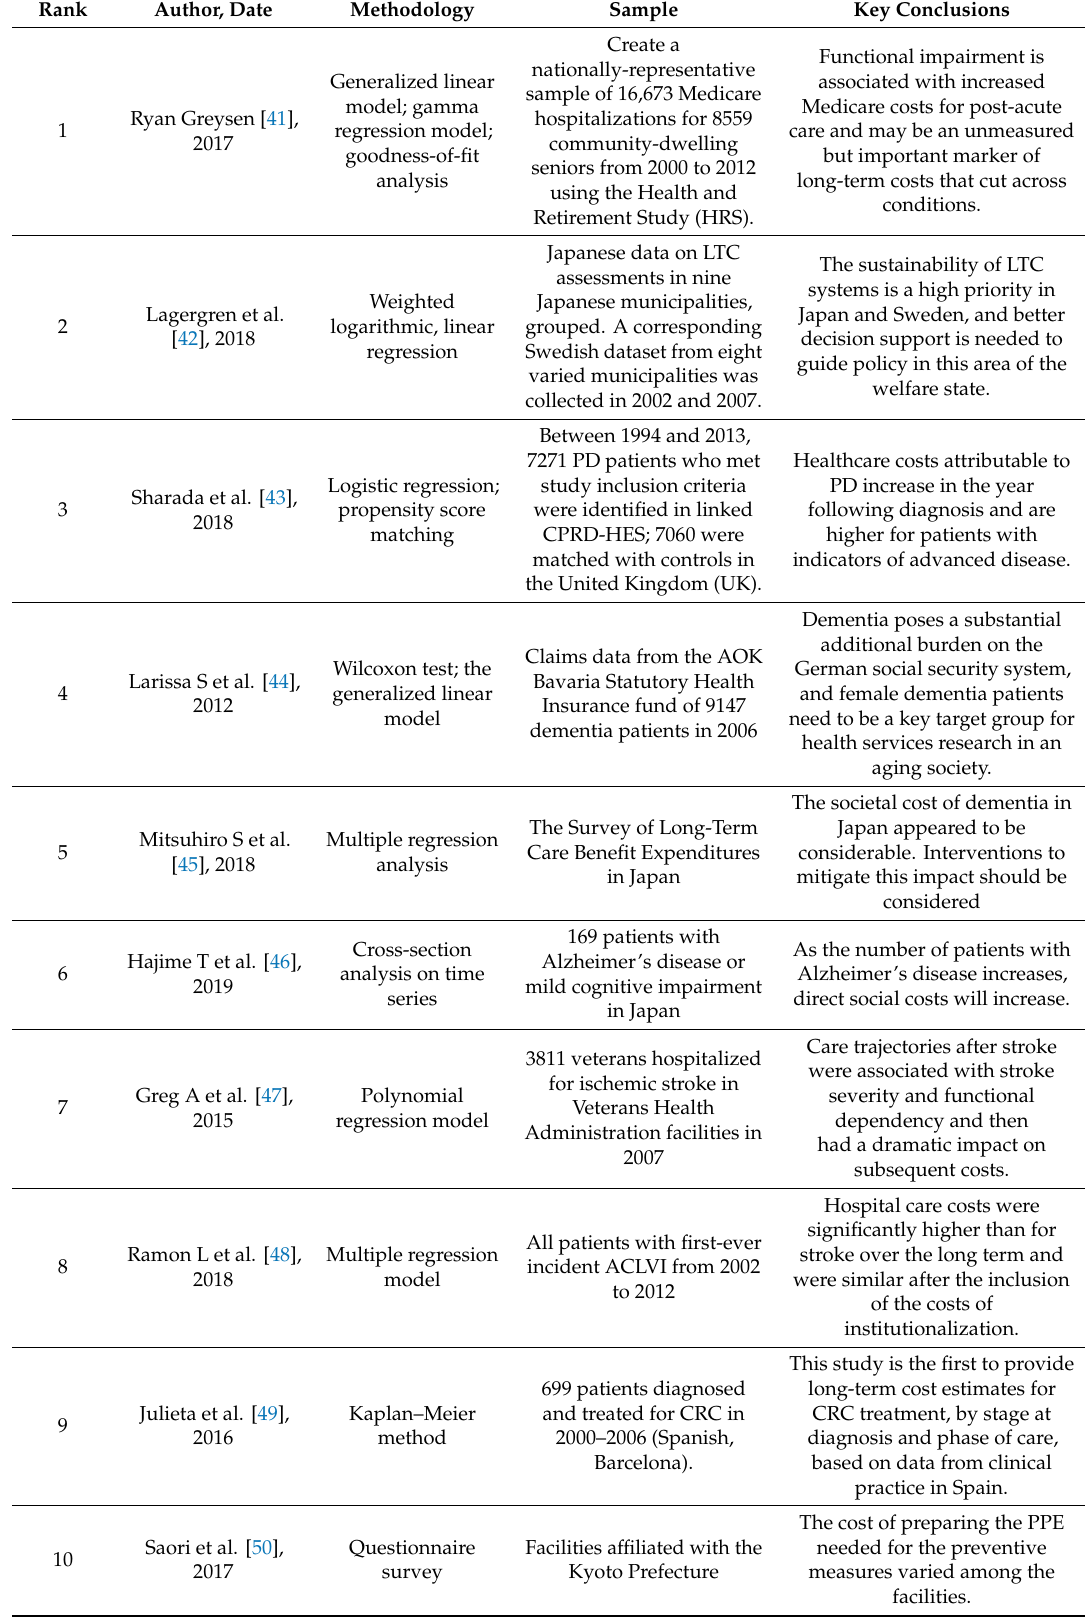
Table 3. Literature related to the measurement of LTC costs in other